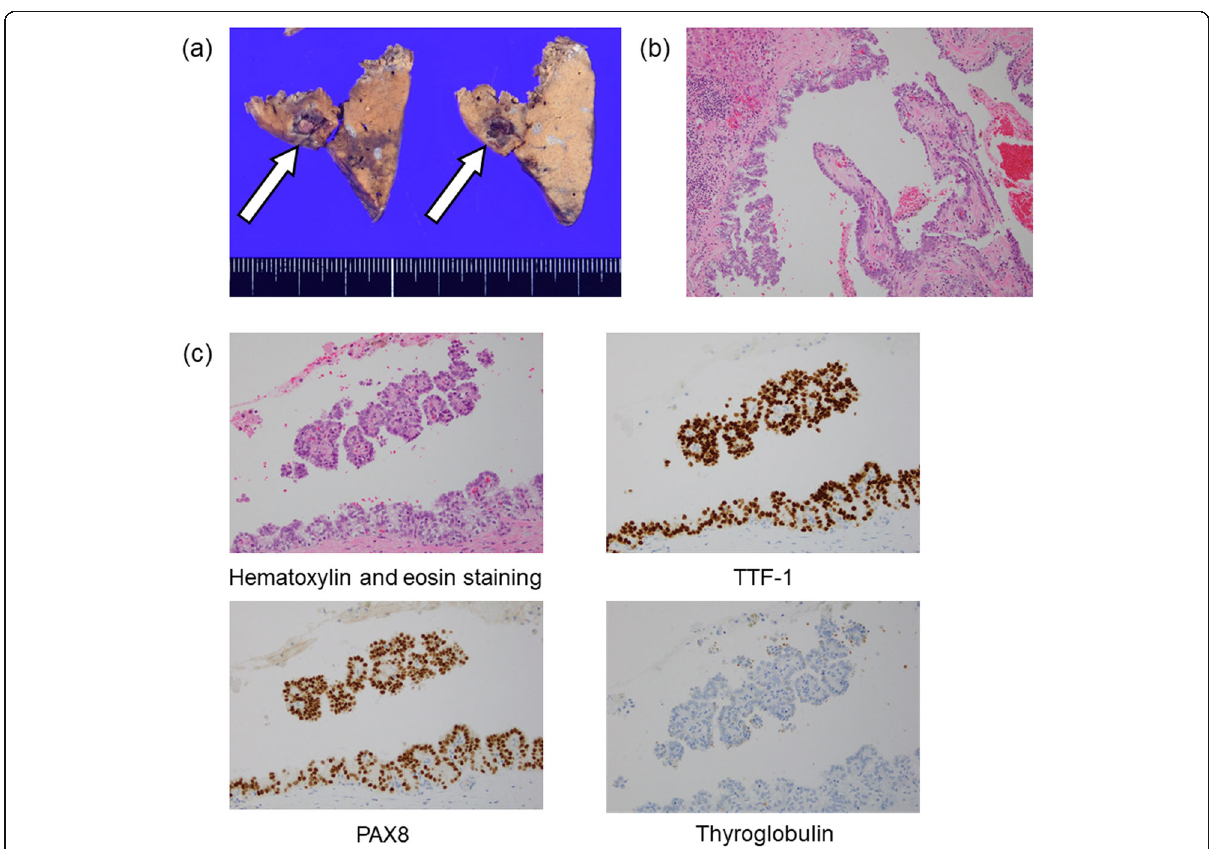
Fig. 2 a Pathological finding showing a dark brown tumor (arrow). b Microscopically, the tumor consists of atypical cell proliferation with a papillary structure. c Immunohistochemically, the resected specimen revealed that the tumors are positive for thyroid transcription factor-1 and paired box 8 and slightly positive for